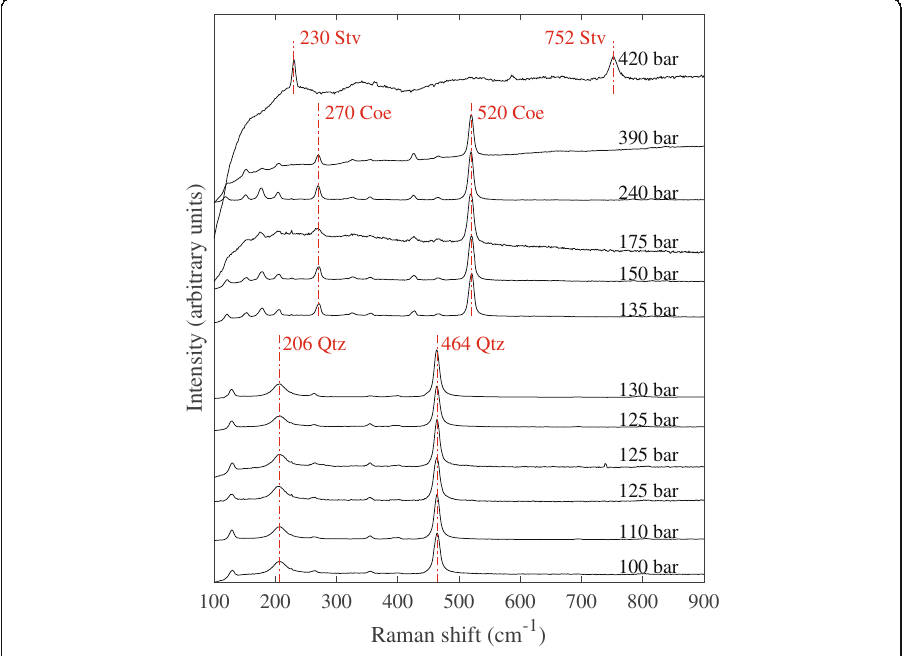
Fig. 5 The Raman spectra from recovered SiO 2 samples obtained from the experiments listed in Table 1. Characteristic peaks of quartz, coesite and stishovite are labelled by the abbreviations ‘ Qtz ’ , ‘ Coe ’